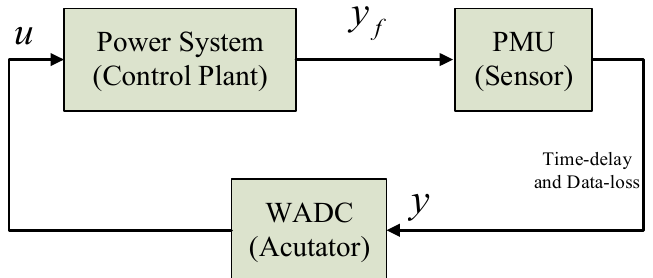
Figure 1. Illustrative diagram of the power system with a wide-area measurement system (WAMS). WADC: wide-area damping controller.